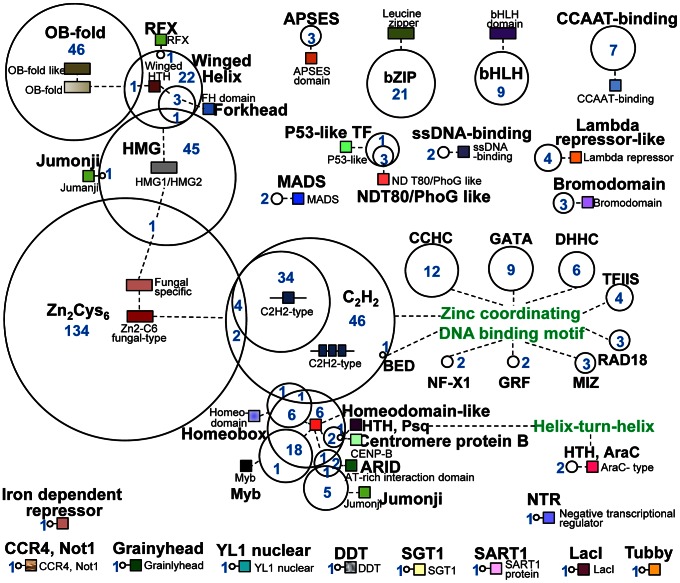
Identification and classification of 495 M.
oryzae TF genes.These TF genes were identified based on a domain search using InterProScan (www.ebi.ac.kr/interpro) and belong to 44 families. The TF families are indicated by circles. Domains are noted by small colored rectangles. The TF genes at the overlapping regions between families indicate those possessing more than one TF motif. Two green-colored letters designate the zinc-coordinating DNA-binding motif and helix-turn-helix motif. The blue-colored number (in the circle or at the left side of the circle) indicates the number of genes in each family.